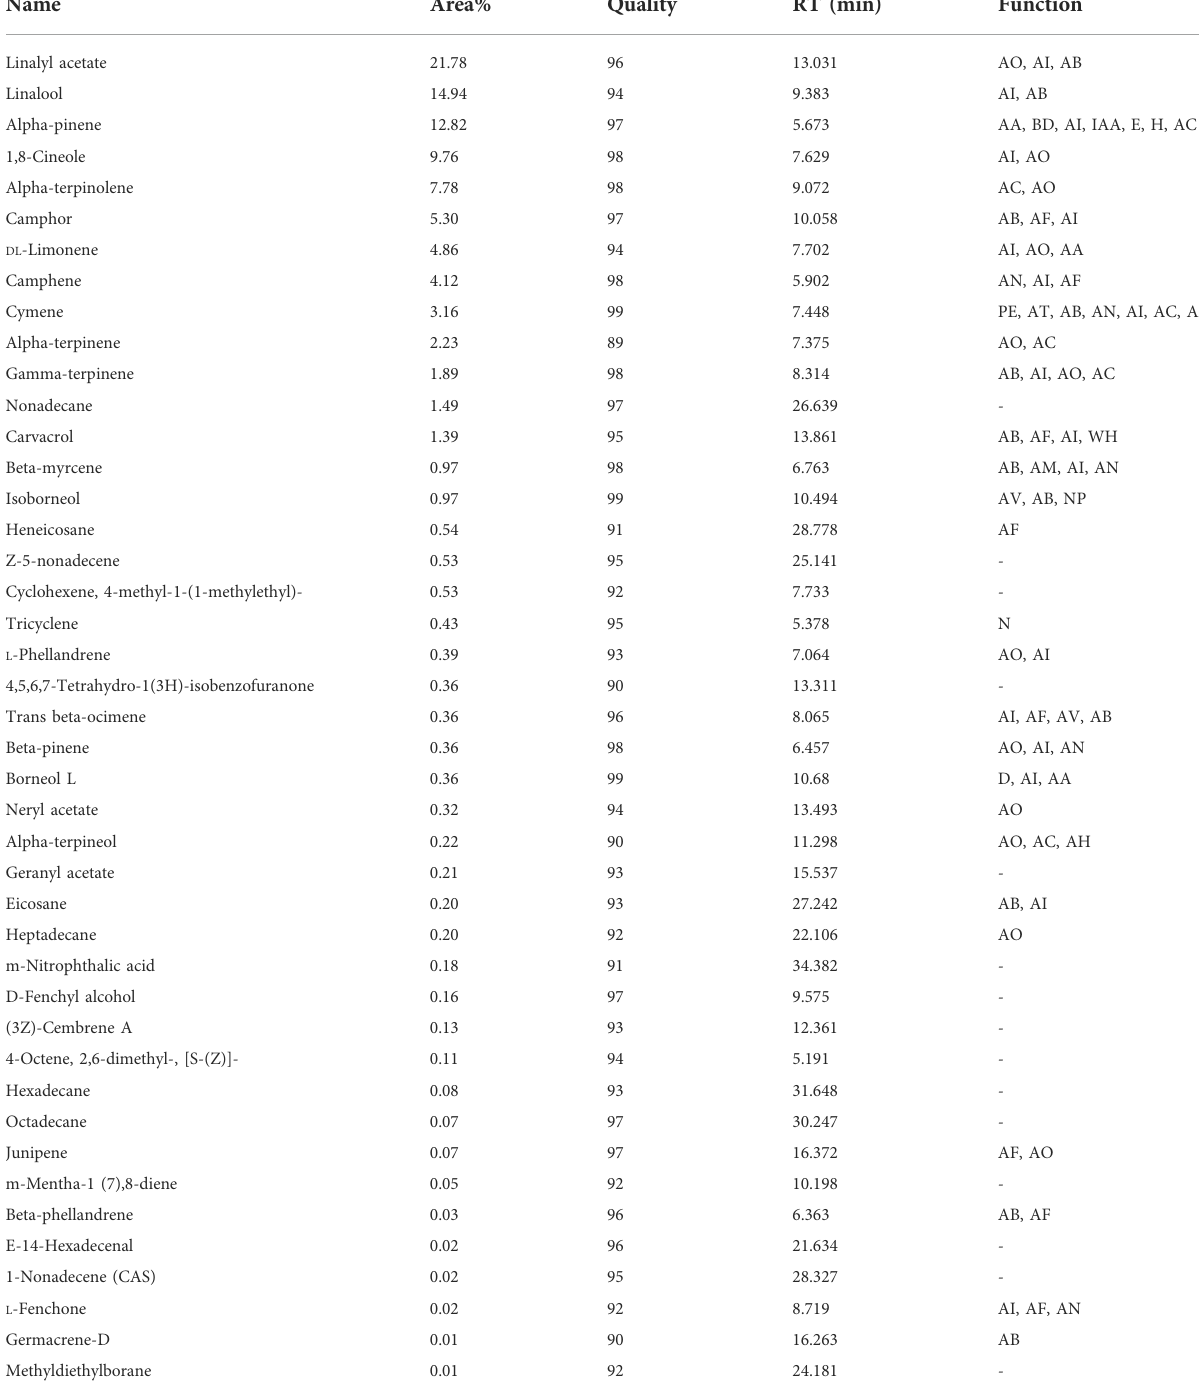
TABLE 3 Chemical composition of the Oliveria decumbens Vent. fl ower as shown from high to low in respect to their presence percentage in the sample. IAA (inhibiting acetylcholinesterase activity), E (euphoria), H (Hypervigilance), NP(neuroprotective), N (norgestimate-ethyl estradiol), AH (antihypertensive), AV